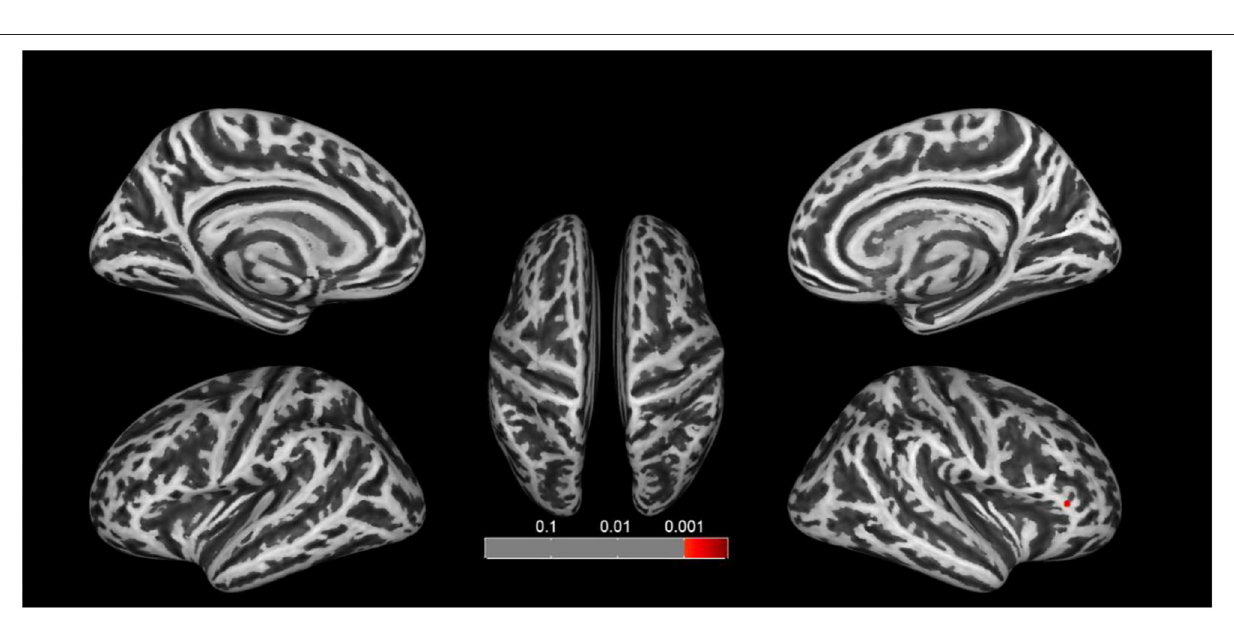
FIGURE 4 | Clusters that significantly varied in terms of sulcal depth in the CA group vs. the HC group. Subjects with congenital amusia had a significantly lower sulcal depth in the right pars triangularis compared to healthy controls ( p < 0.05; false discovery rate-corrected at the cluster